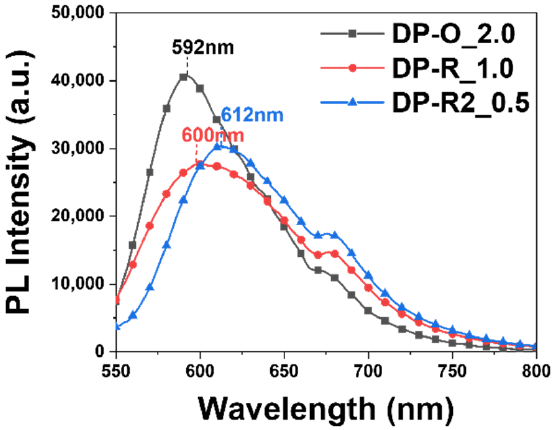
Figure 7. Comparison of PL spectra of DPP ‐ based AIE NPs under the same measurement conditions.